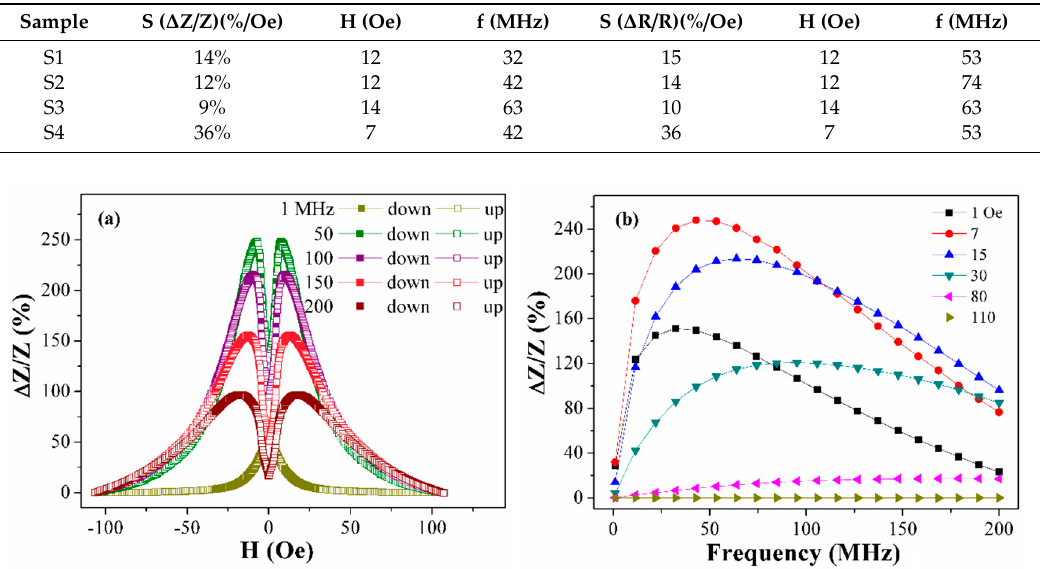
Table 2. Comparison of sensitivity of the MI ratio for total impedance and its real part for